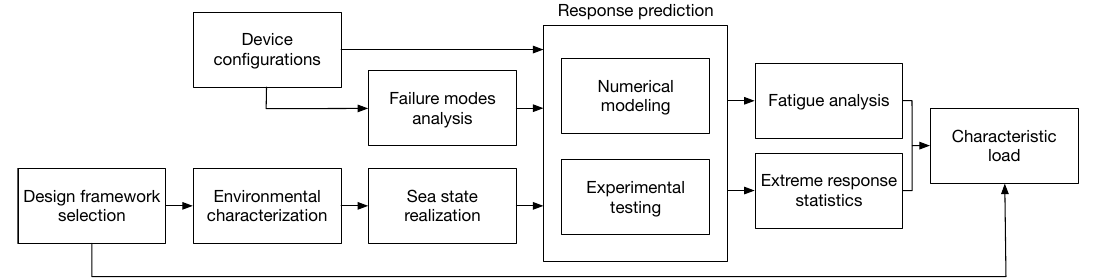
Figure 1. General WEC design workflow with component